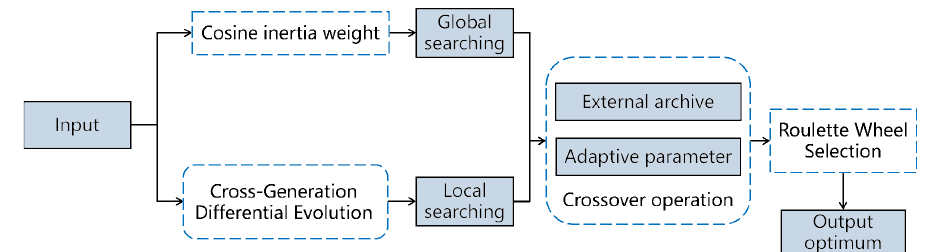
Figure 1. The framework of the